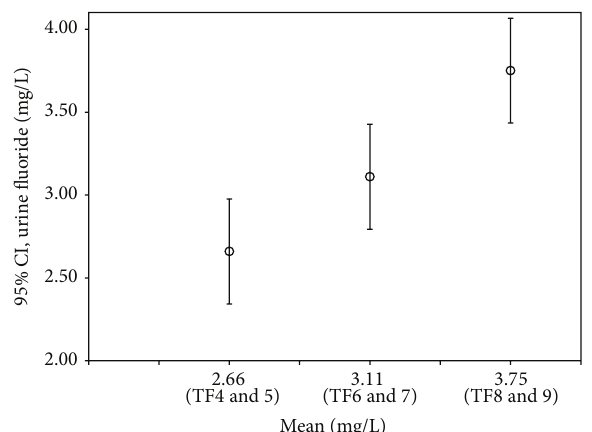
Figure 3: Urine fluoride levels and their relation to dental fluorosis